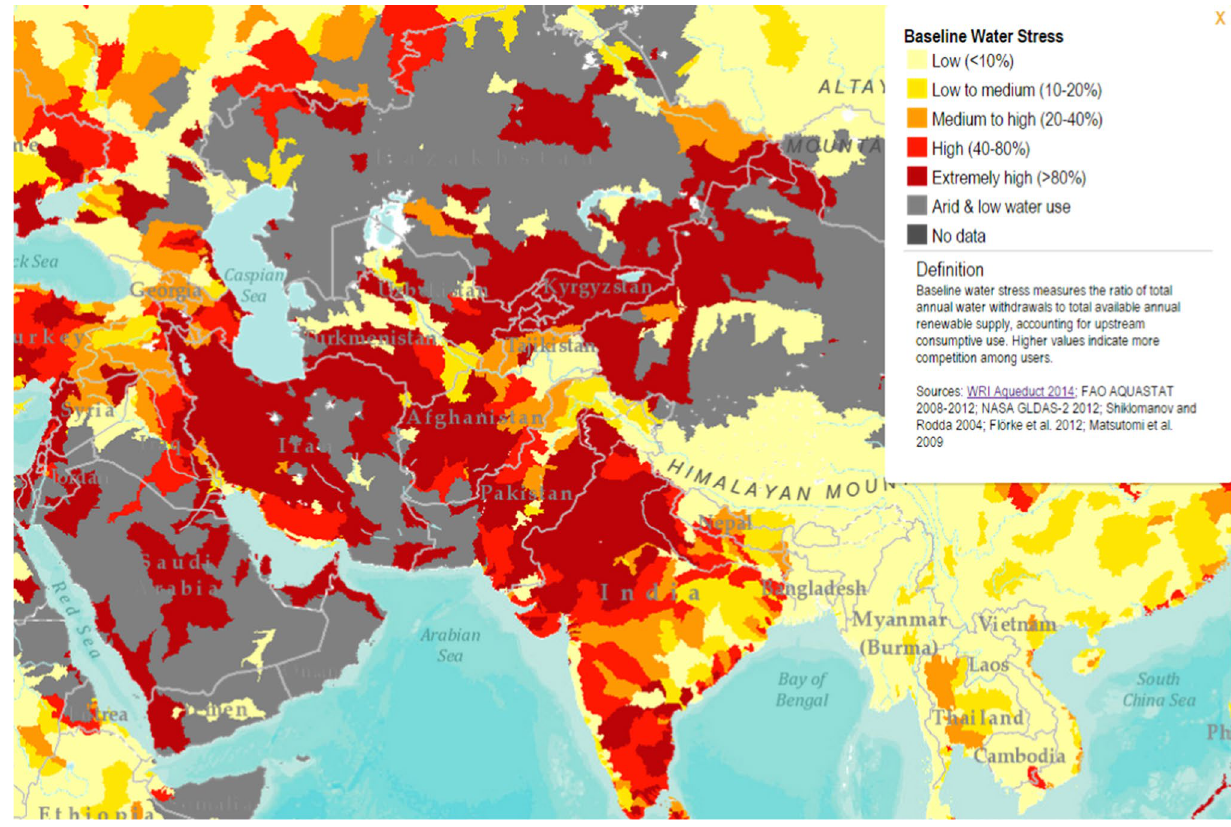
Fig. 1 Baseline water stress satellite map of the world (Otto and Maddocks